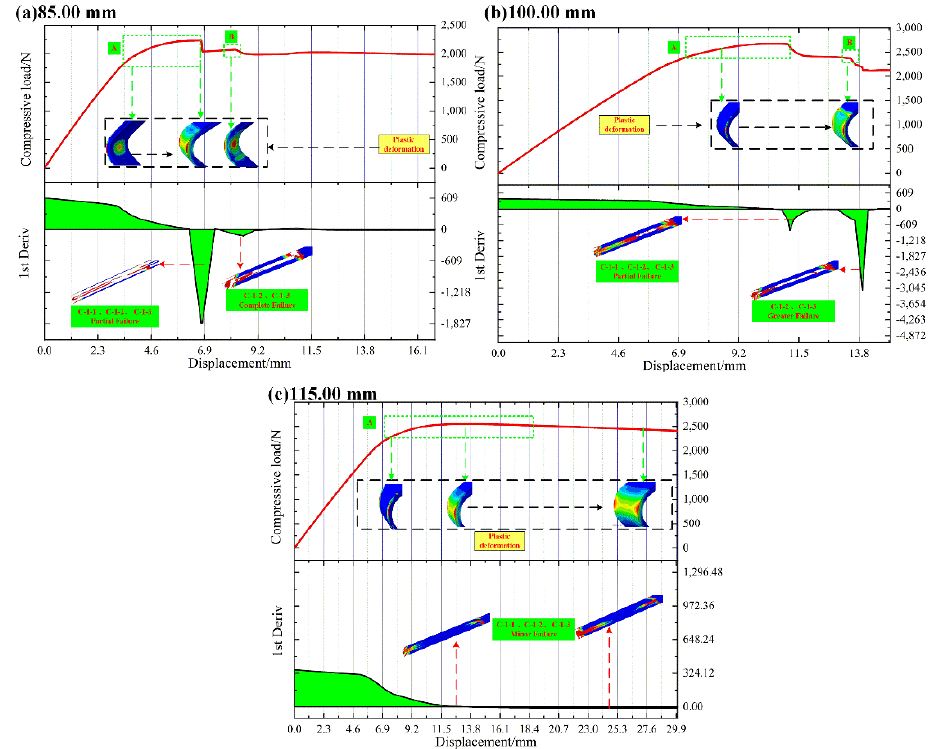
Figure 16. The load–displacement curve and its first derivative curve of the compression simulation of the L-joint with different bonding lengths: ( a ) 85.00 mm, ( b ) 100.00 mm and ( c ) 115.00 mm, and (A) The first load stabilization stage; (B) The second load stabilization stage. Table 5. Simulated failure mode versus compressive